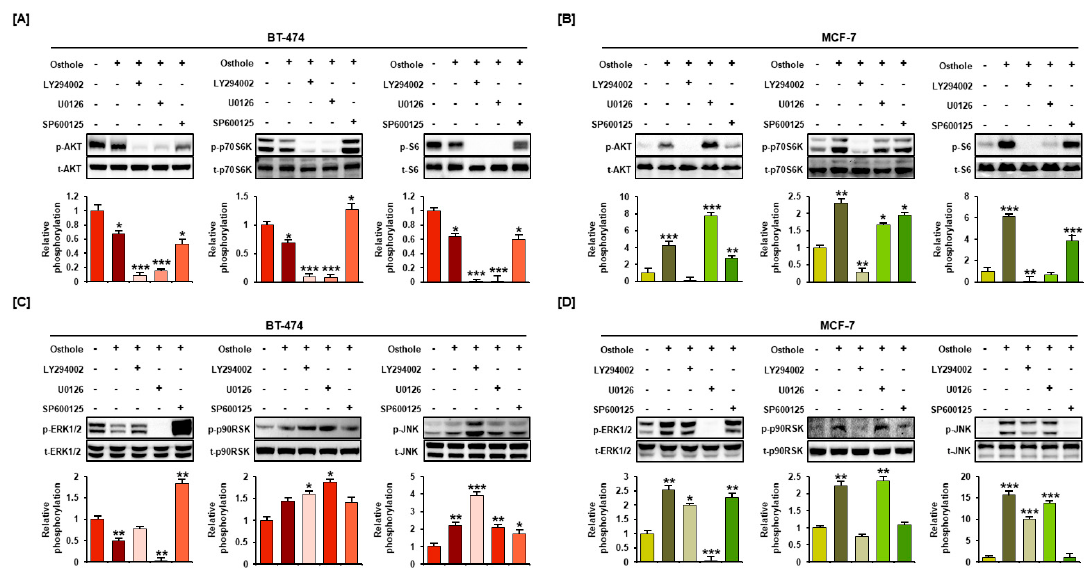
Figure 7. Combinational effect of pharmacological inhibitors on osthole-mediated signaling pathways in human breast cancer cells. After incubation with LY294002 (Akt inhibitor), U0126 (ERK1/2 inhibitor), and SP600125 (JNK inhibitor) for 2 h, BT-474 and MCF-7 cells were treated with 50 μ M osthole for 1 h. Changes in phosphorylation of Akt, p70S6K, S6 ( A , B ), ERK1/2, p90RSK, and JNK ( C , D ) were analyzed by western blotting. The graph shows relative phosphorylation of each protein compared to that in non-treated control (0 μ M). All experiments were performed in biological triplicate and the asterisks indicate statistically significant differences compared to non-treated control (* p < 0.05, ** p < 0.01 and *** p < 0.001).